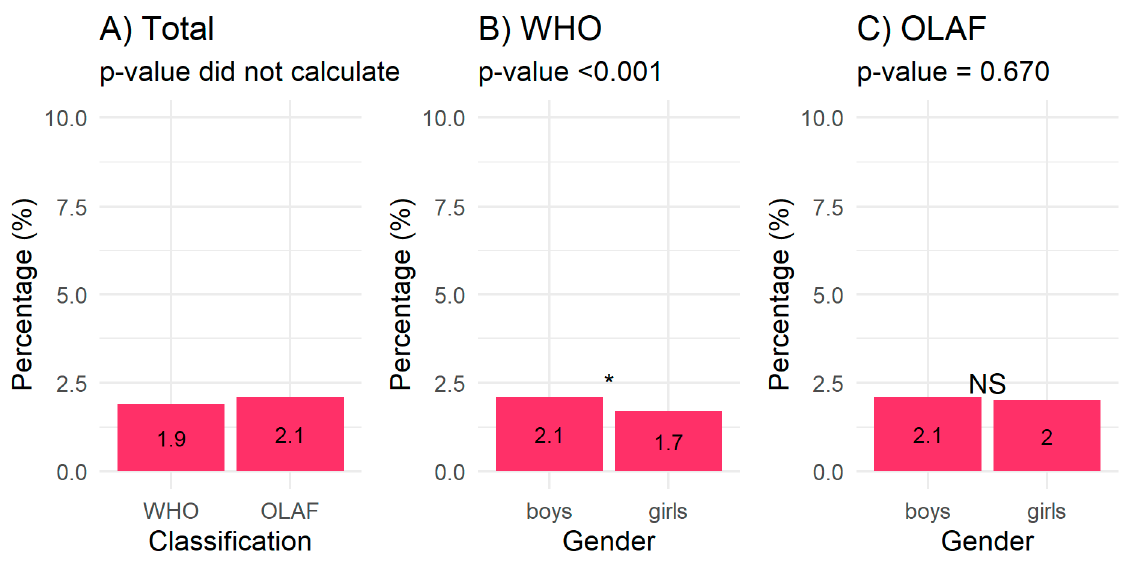
Figure 1. ( A – C ). Prevalence of underweight children by classification method and by gender according to each classification method. *—significant, NS—not significant, OLAF national research project reference charts, WHO World Health Organization.